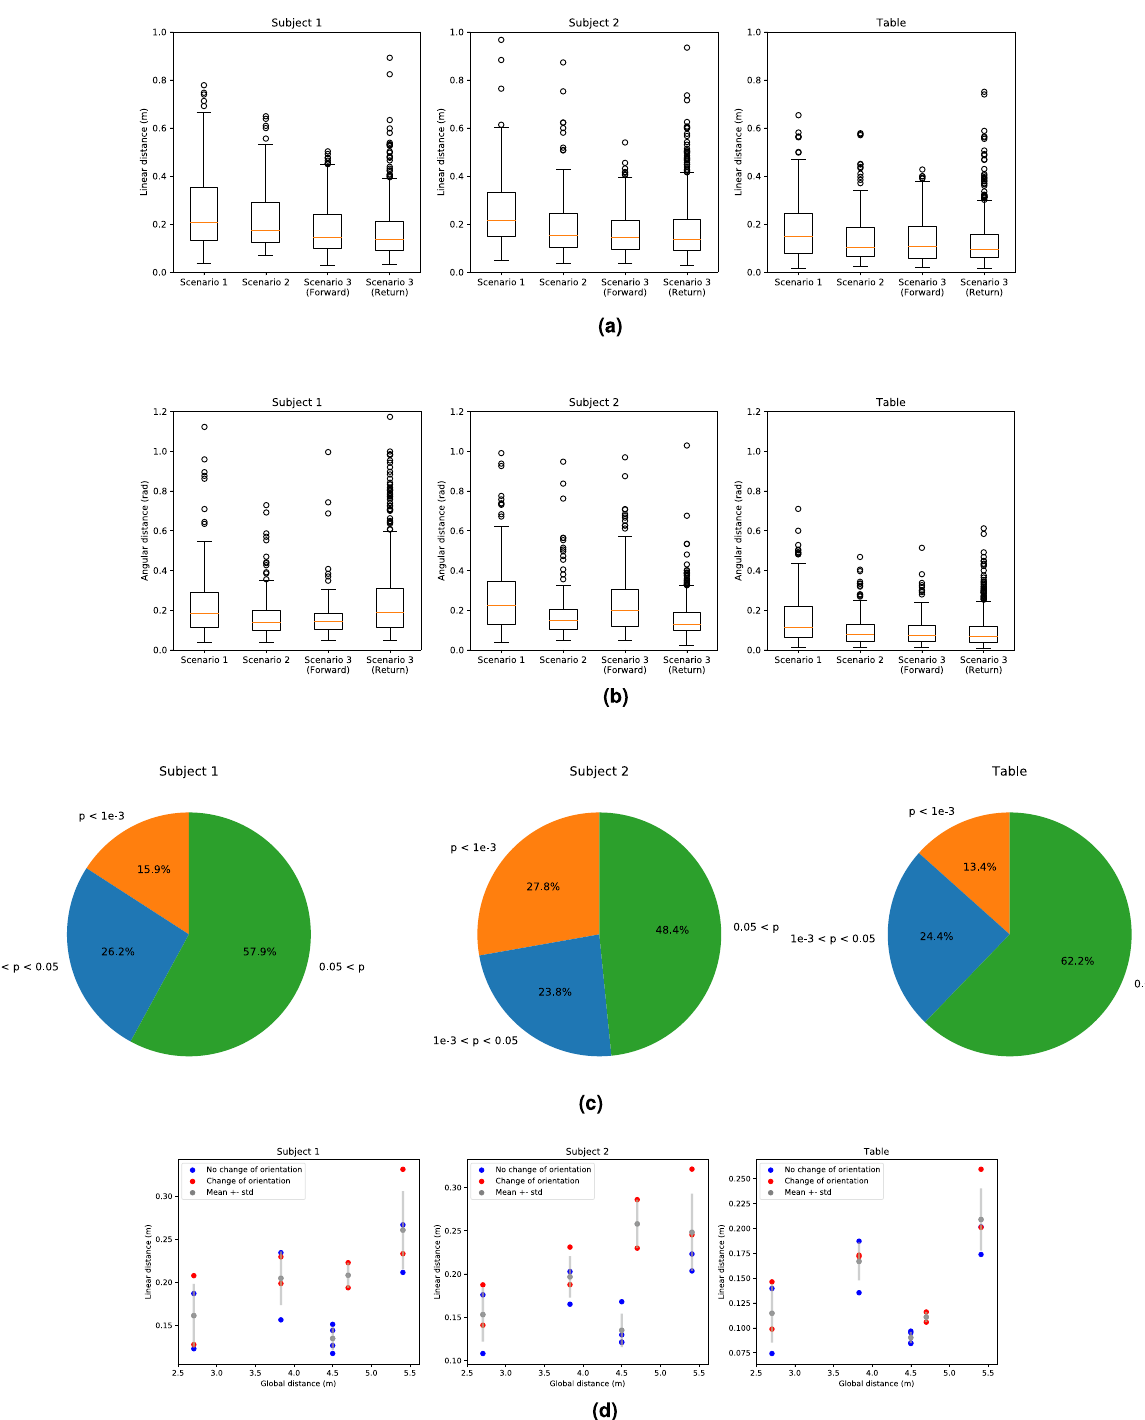
Figure 7. Variability of the performed trajectories. ( a ) Boxplot of the linear distances between the average trajectories and the measured trajectory for all goal positions according to the different scenarios. ( b ) Boxplot of the angular distances between the average trajectories and the measured trajectory for all goal positions according to the different scenarios. ( c ) The pairs returned the table 3 times in the same conditions from each goal position. Thus, we can compute the linear distances between these 3 returns forevery pair and every goal. Kruskal–Wallis tests were performed to assess if these distance are significantly different. These pie charts show the results of these statistical tests. ( d ) Mean linear distances between the average trajectories and the measured trajectories according to the globaldistance . In blue are plotted the distances for the trajectories which require a change of the table’s orientation (Goal 2, 4, 6, 8) while the others are plotted in red. Let us denote, that there is an even number of points of eachcolor for every global distances because there are two achievable configurations per